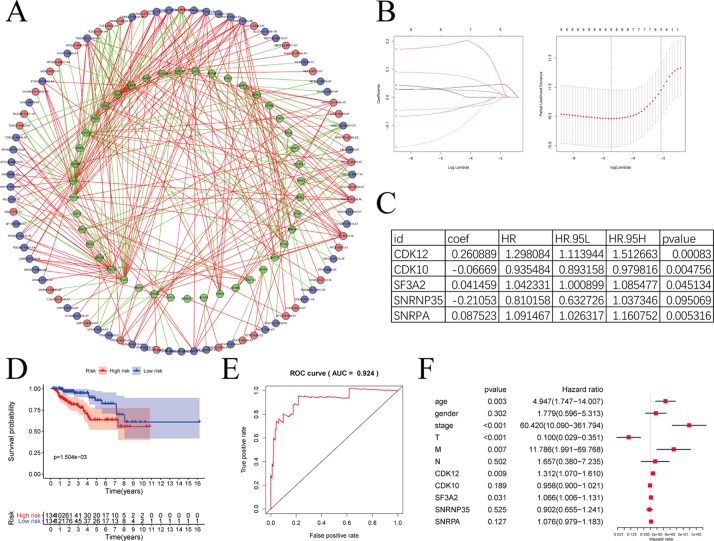
The correlation network between alternative splicing (AS) events and splicing factors in papillary renal cell carcinoma (pRCC). (A) Correlation network between filtered AS events and survival-associated splicing factors (SFs). Green dots were survival associated splicing factors. Red/blue dots were favorable/adverse AS events. Red/green lines represent positive/negative correlations between substances. (B) LASSO Cox analysis of involved SFs. (C) Multivariate Cox regression analysis of LASSO result. (D–E) The prognostic value of SFs presented by overall survival (OS) and ROC curves. (F) Multivariate analyses containing clinical factors and five key genes.